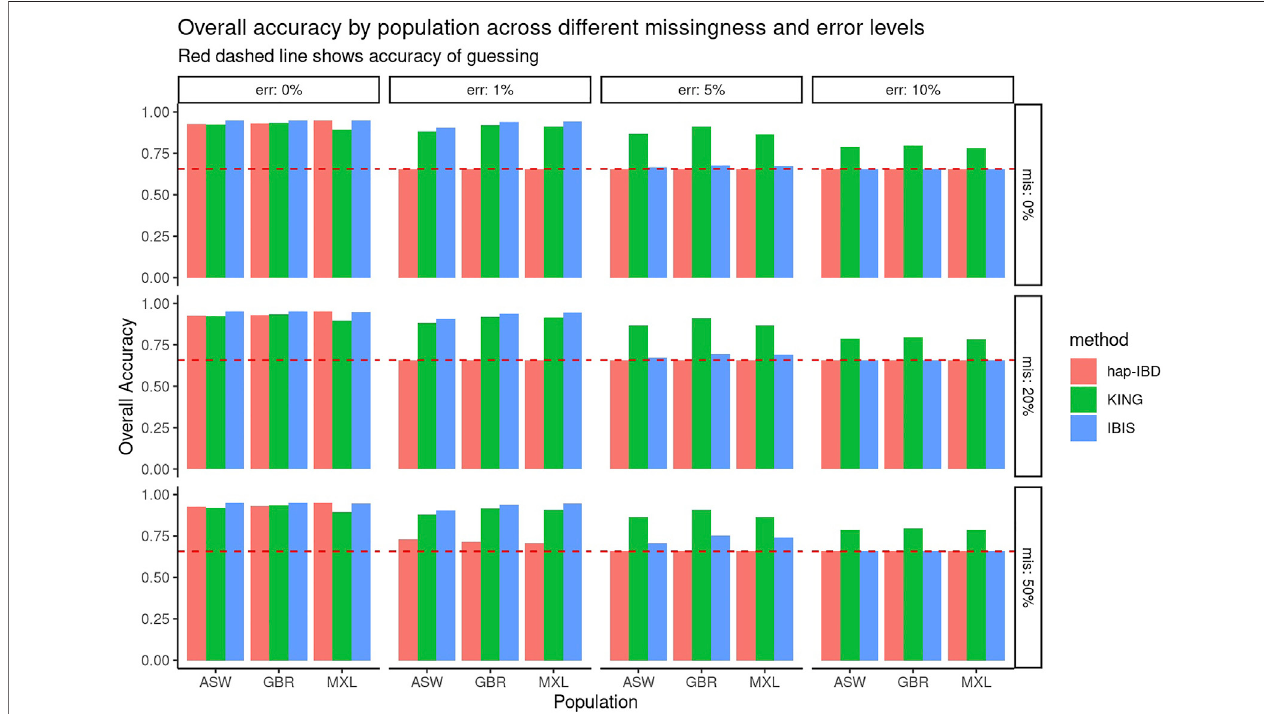
FIGURE 1 | Overall classi fi cation accuracy using default parameters. Panels show the genotyping error increasing in panels going left-to-right and missing data rates increasing panels going top-to-bottom. Individual bars within each panel show the classi fi cation accuracy within each simulated population. This graphic shows roughly equivalent accuracy with zero error but decreased accuracy for both IBD segment methods in comparison to KING with a higher genotyping error.